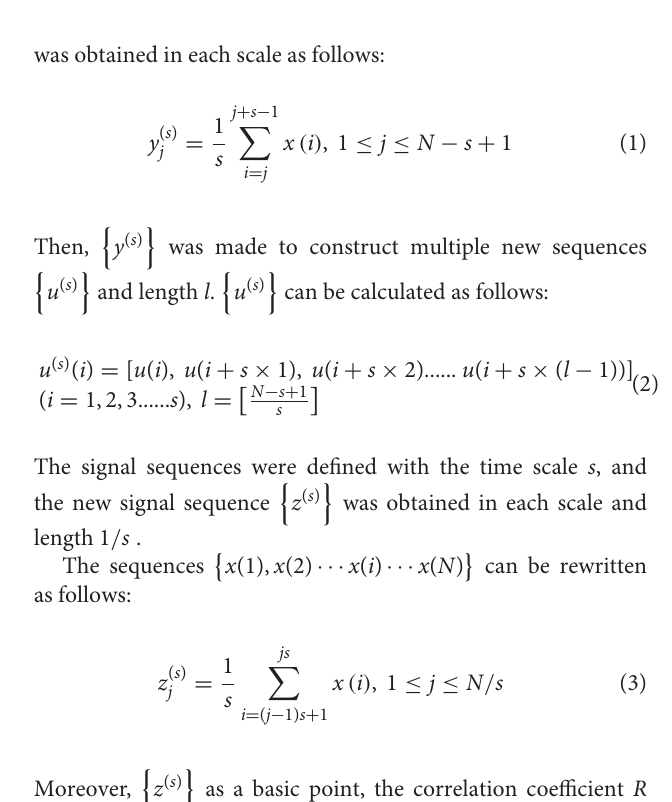
FIGURE 1 | (A) Experimental process: analysis electroencephalogram (EEG) signal pre- and post- neurofeedback training (NFT) and the session of NFT. (B) EEG signal analysis: collected EEG, data preprocessing, and feature extraction. (C) Analysis process: evaluating the effect of NFT. Part 1 is the comparison between MSE and WMMSE. In part 2, to evaluate the effect of NFT, the first step is screening by LZC, and the second step is the accurate analysis of WMMSE. (D) The process of NFT. (E) Clinical application of